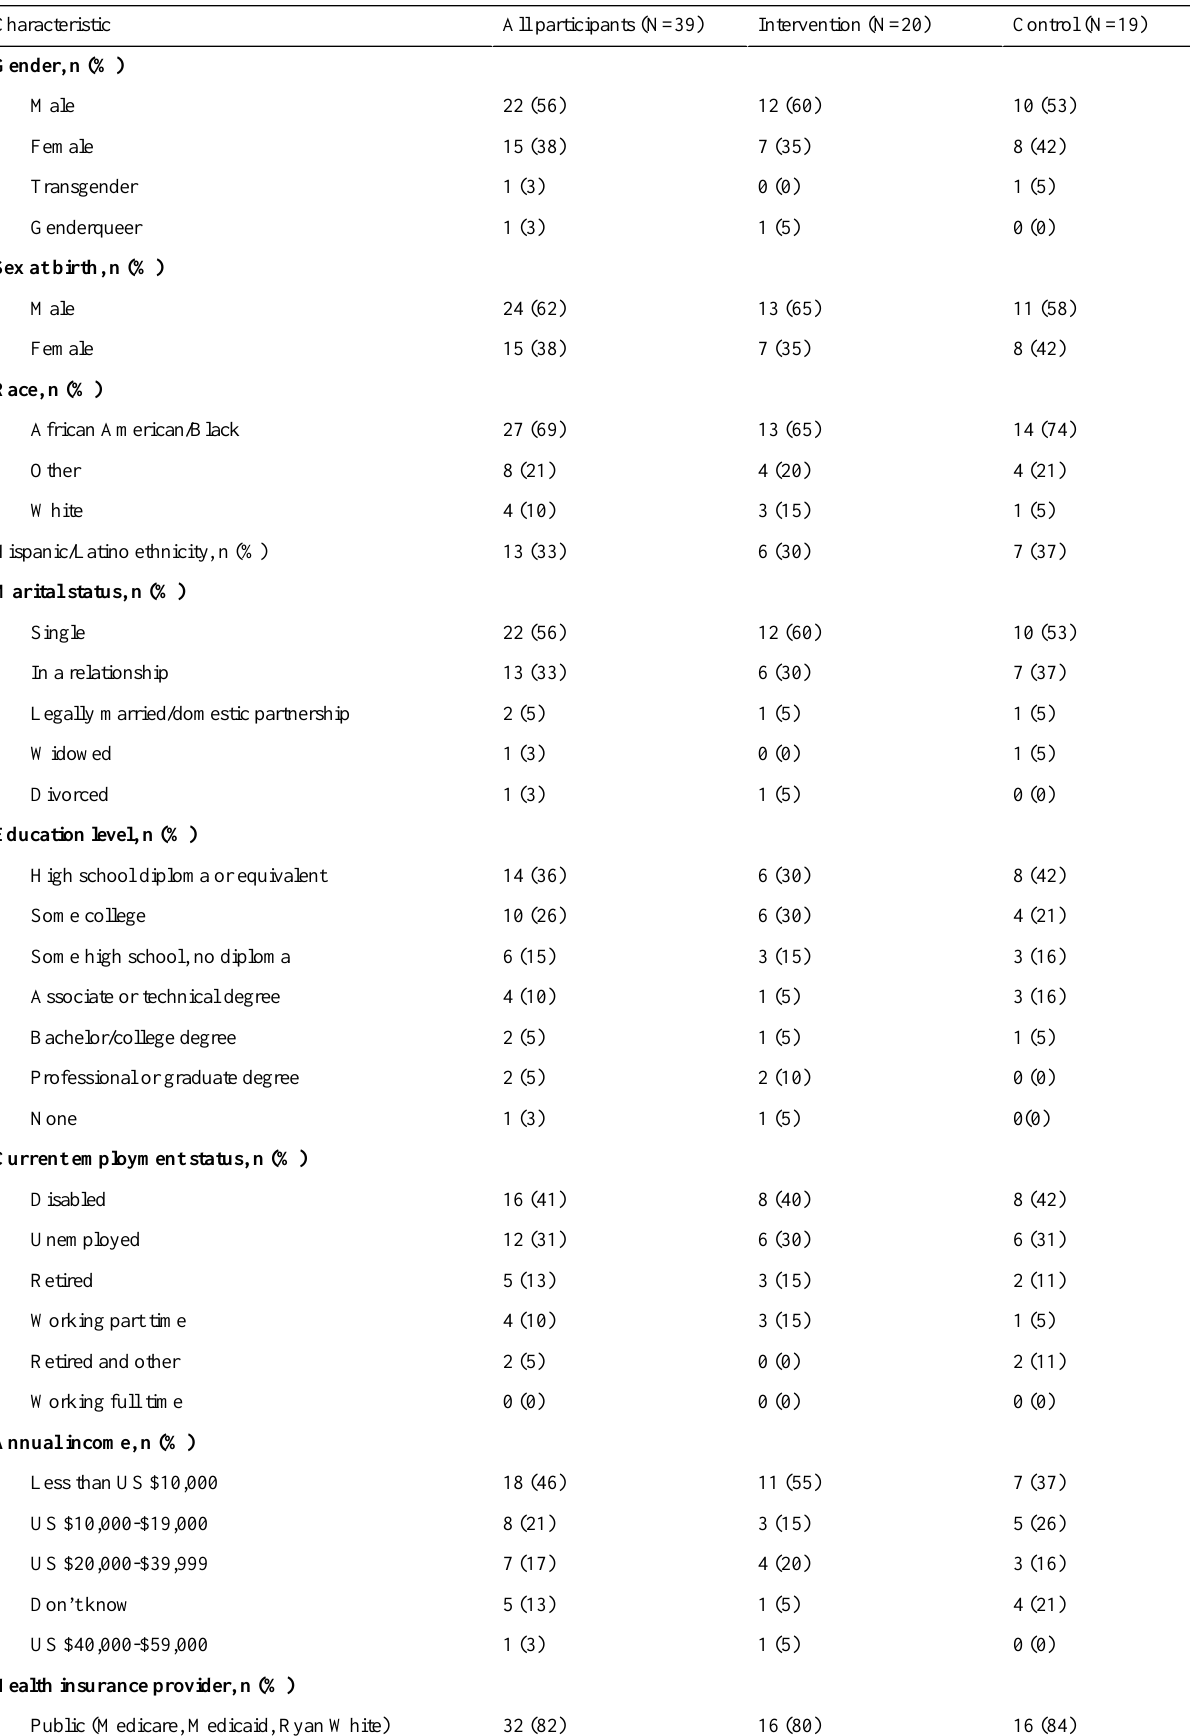
Table 1. Characteristics of the study participants